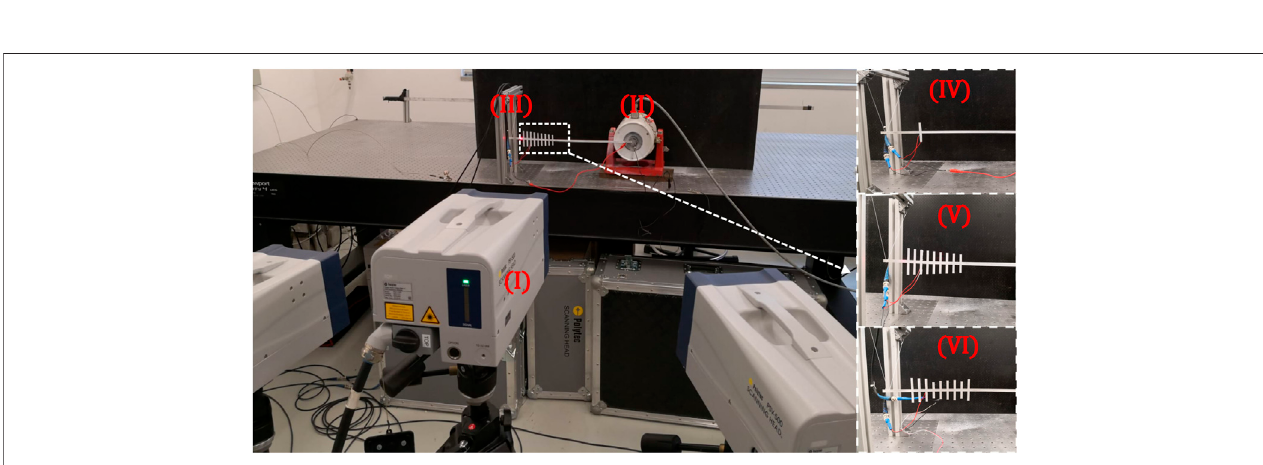
FIGURE 4 | Experimental setup. The wave fi eld is measured using a 3D laser vibrometer (I). The beam is forced using an electrodynamic shaker (II), while the opposite side is suspended through elastic cables (III). A zoomed-in view of the lone cell (IV), linear array (V) and random array (VI) is reported in the right insets.